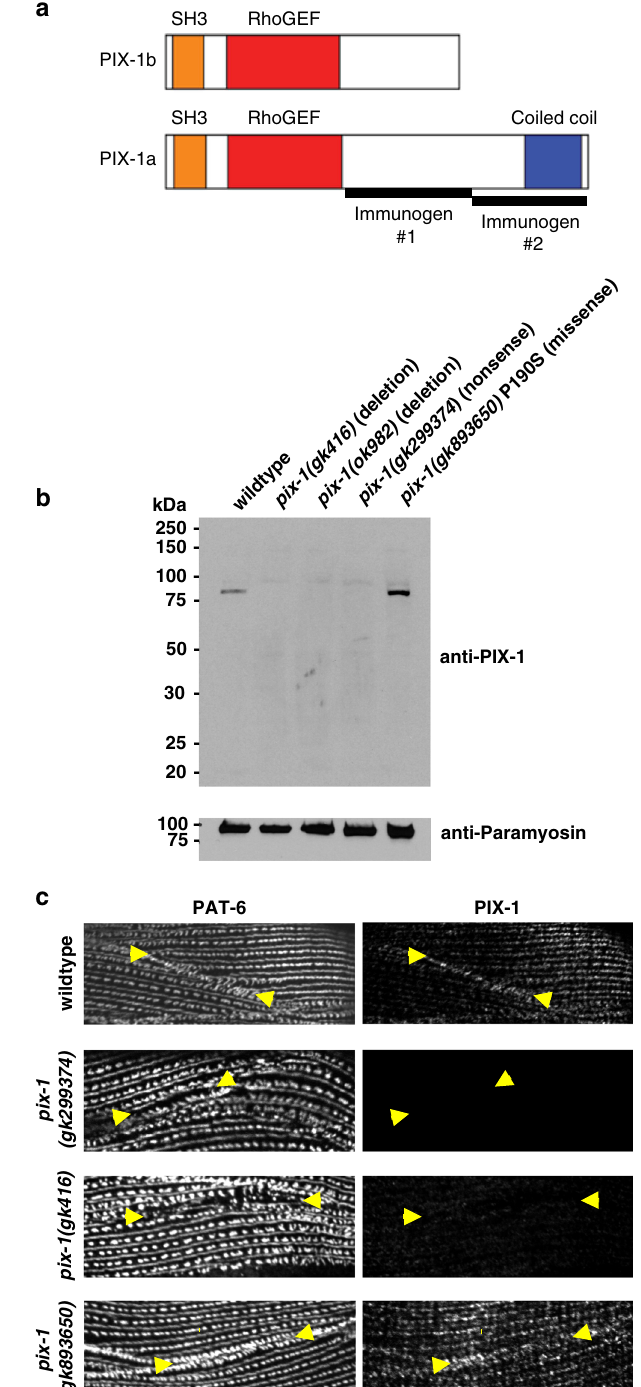
(Fig. 9b) using antibodies to two different IAC components, UNC-95 and PAT-6 ( α -parvin), show a closed zipper in wild type, whereas in pix-1(gk893650) the zipper appears open. This